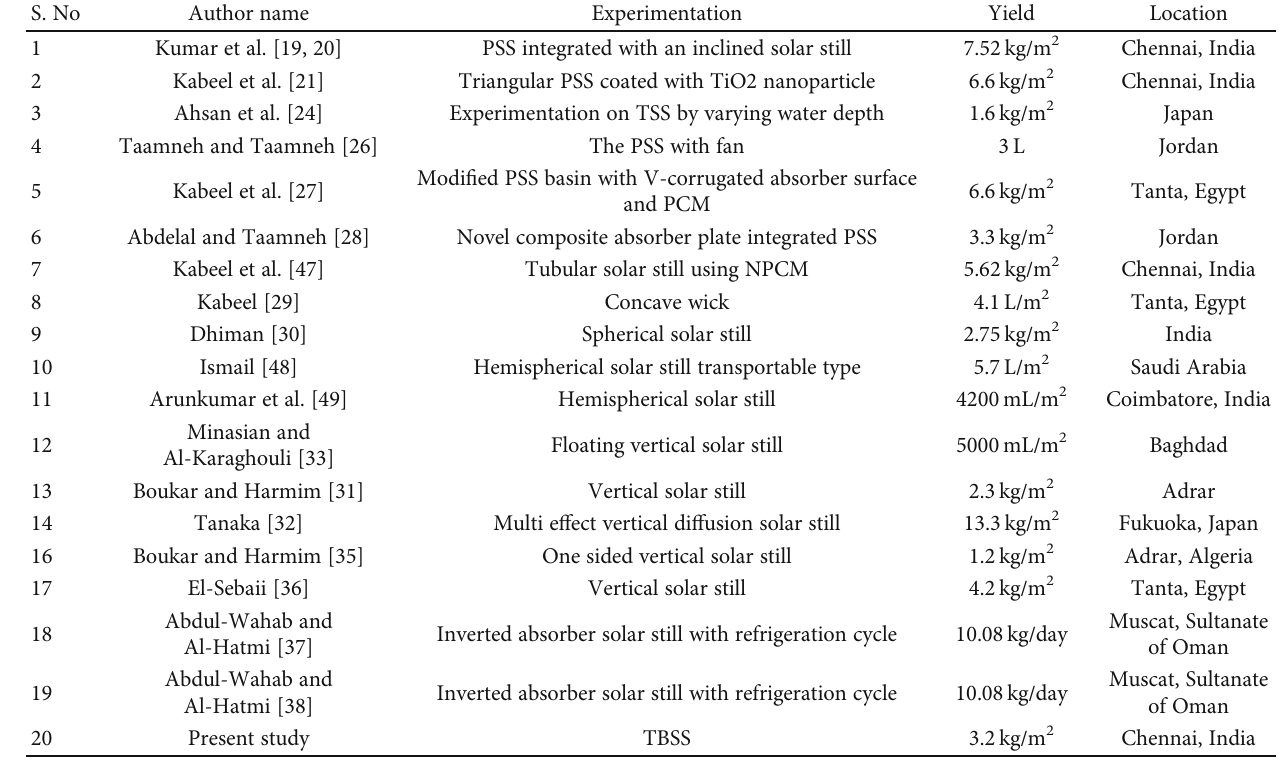
Table 3: Comparison of present testing with previously published